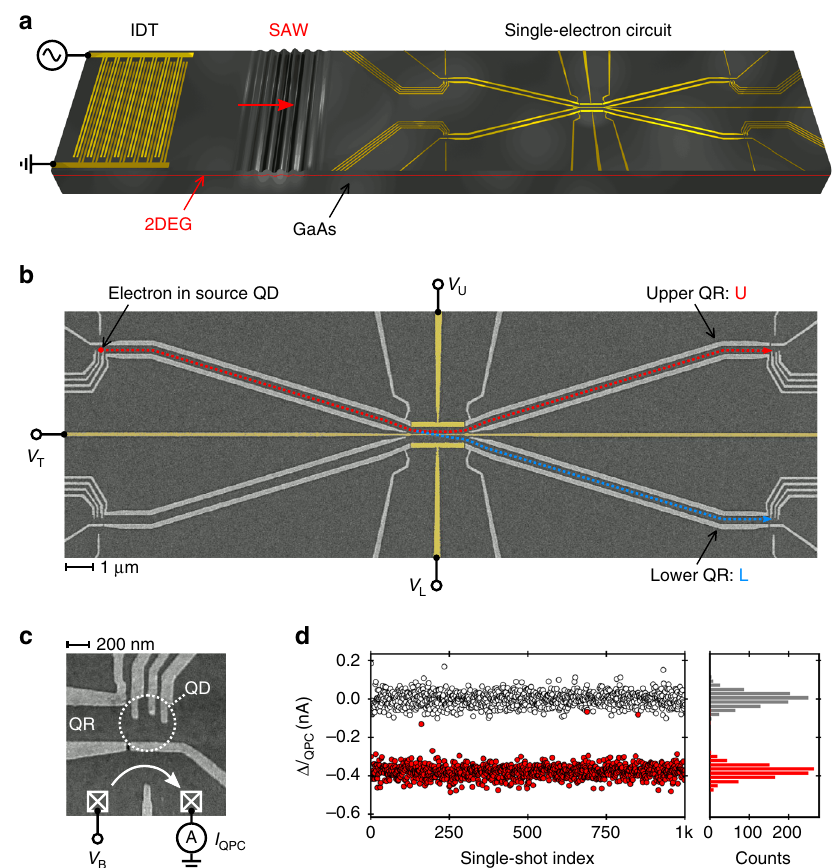
Fig. 1 Sound-driven circuit of coupled quantum rails. a Schematic of the experimental set-up. An interdigital transducer (IDT) launches a SAW train towards the single-electron circuit, which is realised via metallic surface gates in a GaAs/AlGaAs heterostructure. b SEM image of the quantum rails (QR) with indications of the transport paths, U and L, and the voltages to control the coupling region. c SEM image of the lower receiver quantum dot (QD) with indication of the coupled quantum rail (QR) and the close-by quantum point contact (QPC). d Jumps in QPC current, I thousand SAW-driven single-shot transfers with (red) and without (grey) initial loading of a solitary electron at the source